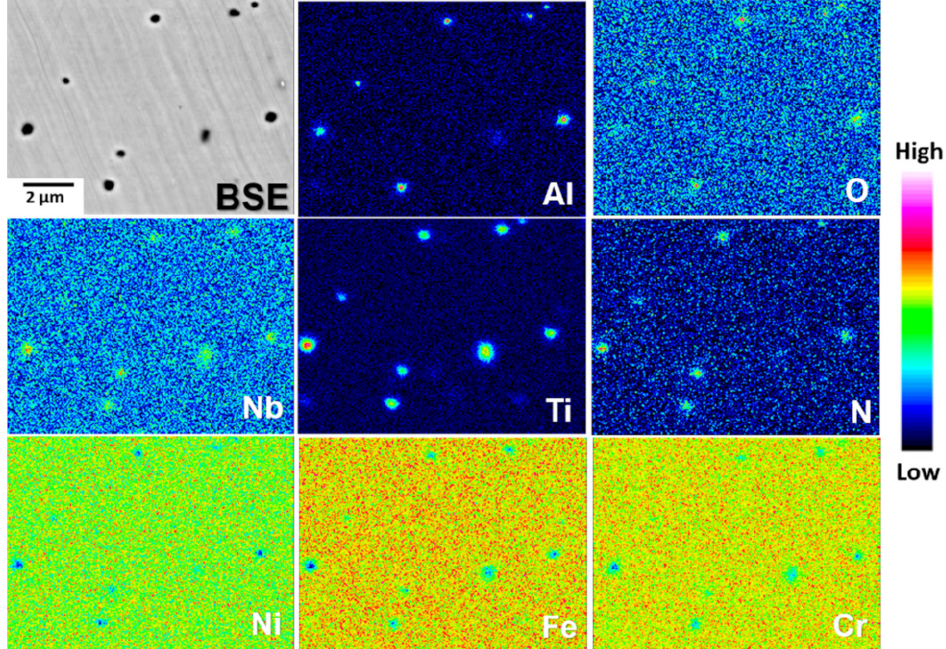
Figure 2. EPMA element maps showing the formation of Al 2 O 3 and TiN in the EBM IN718 as-built specimen along the building direction [17] (BSE: Backscattered Electrons